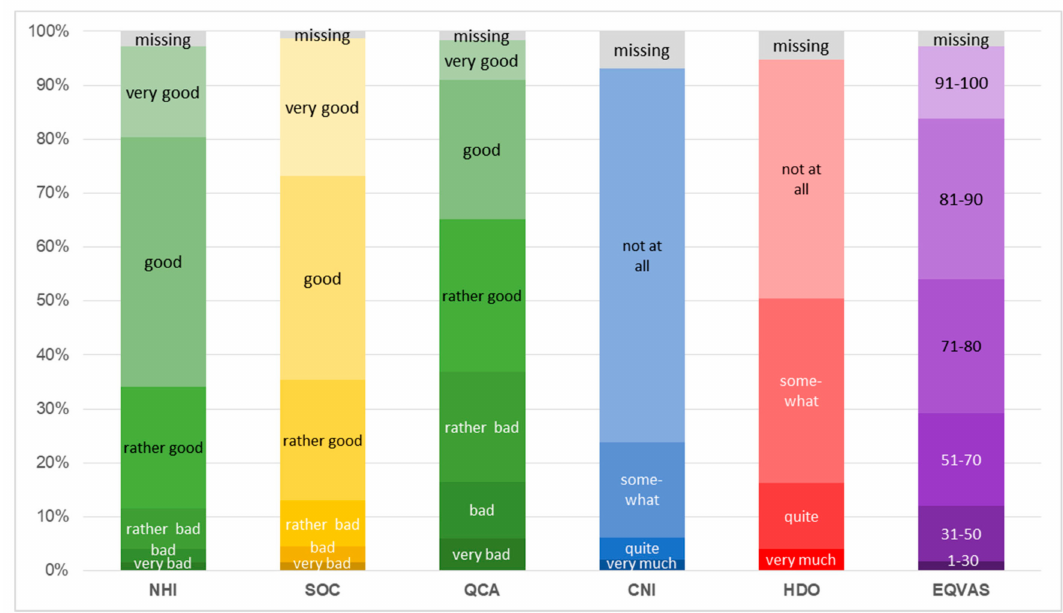
Figure 4. Relevant urban variables (rating of neighborhood health infrastructure (NHI), rating of one’s social network (SOC), rating of neighborhood air quality (QCA), cold stress (night / winter / indoors) (CNI), heat stress (day / summer / outdoors) (HDO); identified by LR) and dependent variable (EQVAS).